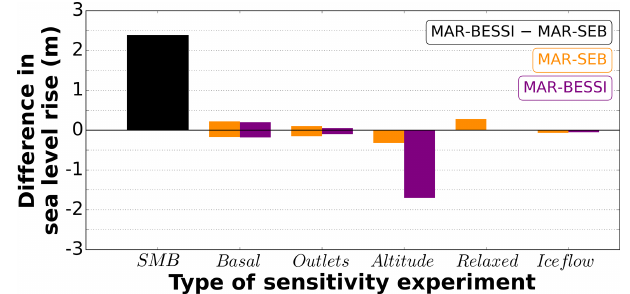
Figure 6. Differences between the minimum Eemian ice sheet sim- ulated by the respective sensitivity experiments: SMB (black): dif- ference between the control and the SMB experiment (MAR-SEB and MAR-BESSI, respectively); basal : experiments with changed friction for the entire ice sheet; outlets : experiments with changed friction at the outlet glaciers; altitude : experiments without the SMB–altitude feedback; relaxed : experiment with a larger, relaxed initial ice sheet; ice flow : experiments with 2-D SSA instead of the default 3-D higher-order ice flow approximation. The different SMB forcing is shown in orange (MAR-SEB) and purple (MAR- BESSI). The basal/outlets experiments show positive and negative values because they are performed with enhanced and reduced fric- tion. The exact values are given in Table 3.